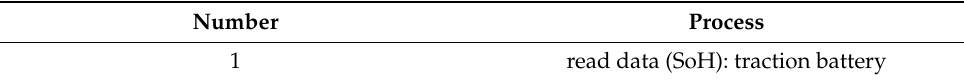
Table A3. Activities of the main processes “classification” and “disassembly”: capacity determination, if battery system is still in vehicle.